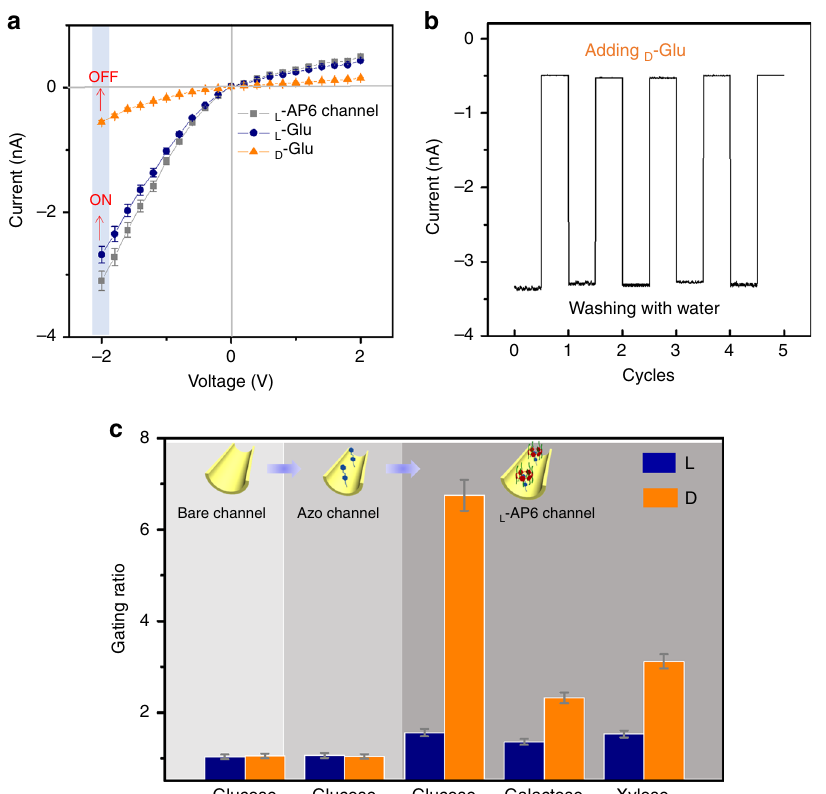
Fig. 4 A biomimetic chiral-driven ionic gate. a I – V curves of the L -AP6 nanochannel in 0.1 M KCl electrolyte in the presence of 1 mM glucose enantiomers; b responsive switchability of the chiral-driven ionic gate: the variation in the reversible ionic currents of the L -AP6-modi fi ed nanochannel measured alternately at a constant voltage of − 2 V with the addition and removal of D -Glu; c a bar graph of gating ratios I o / I glucose at – 2 V after adding the above saccharide enantiomers in a bare channel, AZO channel, and L -AP6 channel, respectively. Standard deviation is ±5% and is used for describing the error bars. Each dataset in two cases is tested fi ve times, respectively